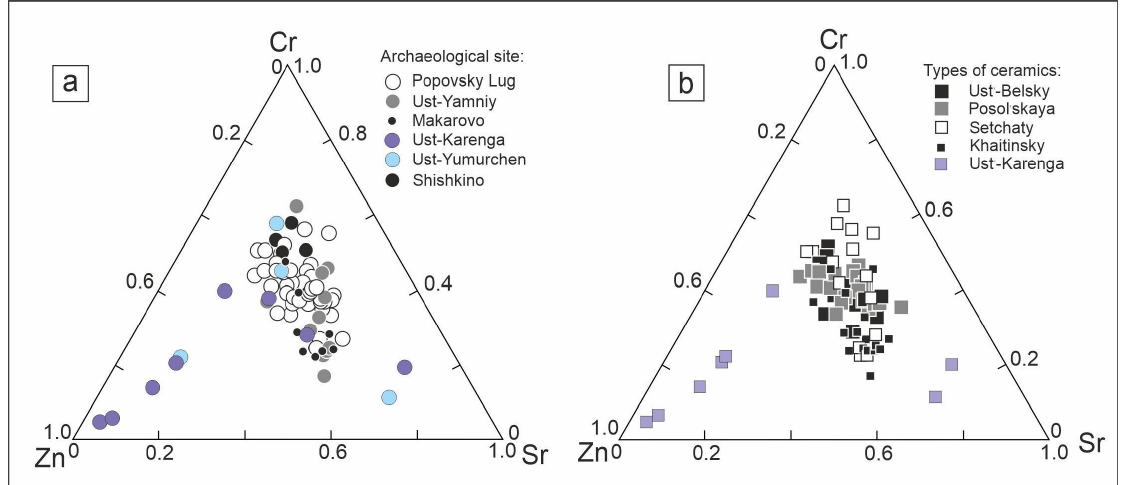
Figure 2. Ternary diagrams for Zn, Cr, and Sr divided by archaeological site ( a ) and type ( b